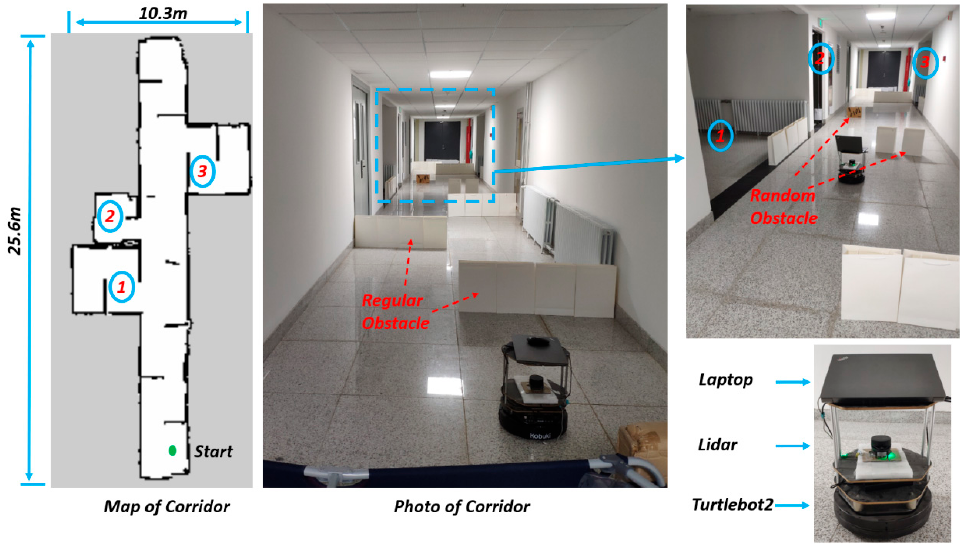
Figure 11. The diagram of the equipment and the experimental environment.